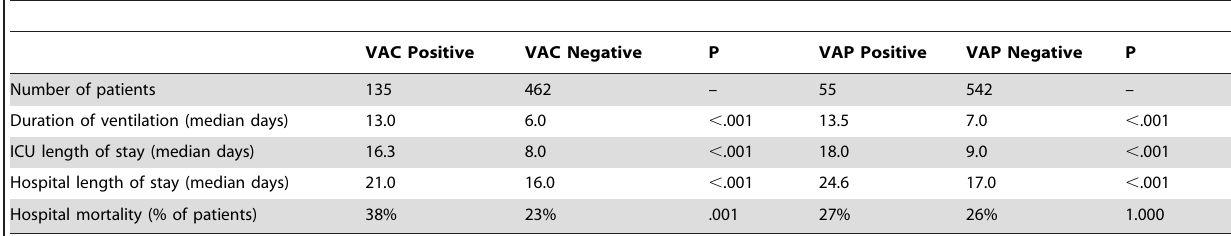
Table 2. Comparison of outcomes for ventilator-associated complication positive and negative patients and ventilator-associated pneumonia positive and negative patients.